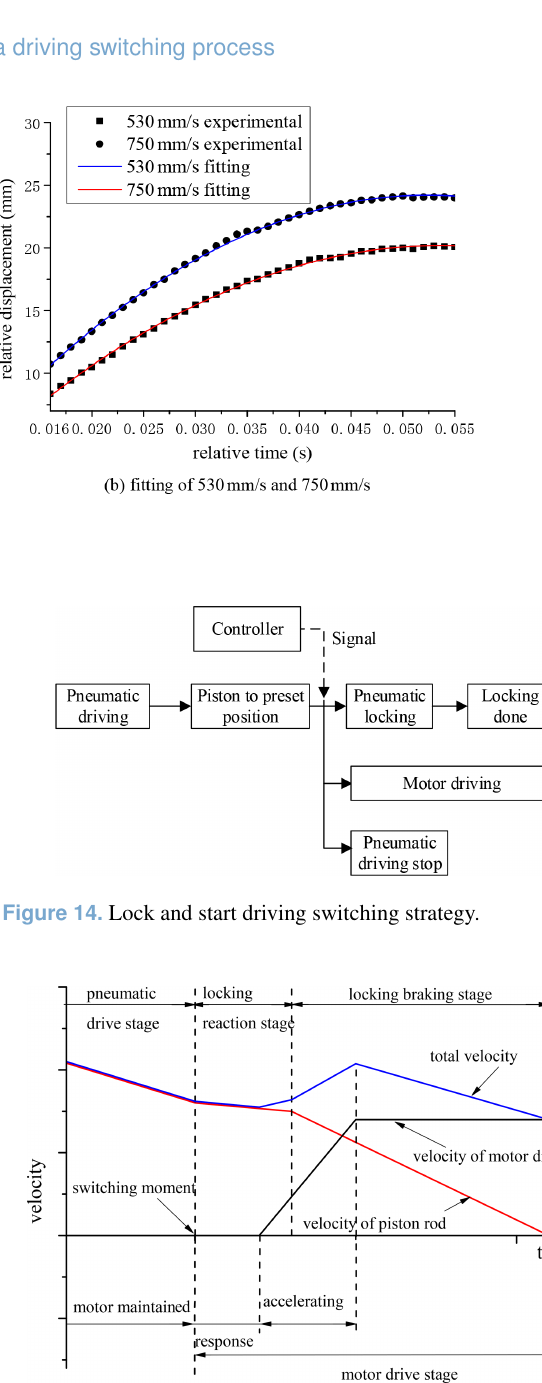
Figure 15. Velocity in the switching process of the lock and start